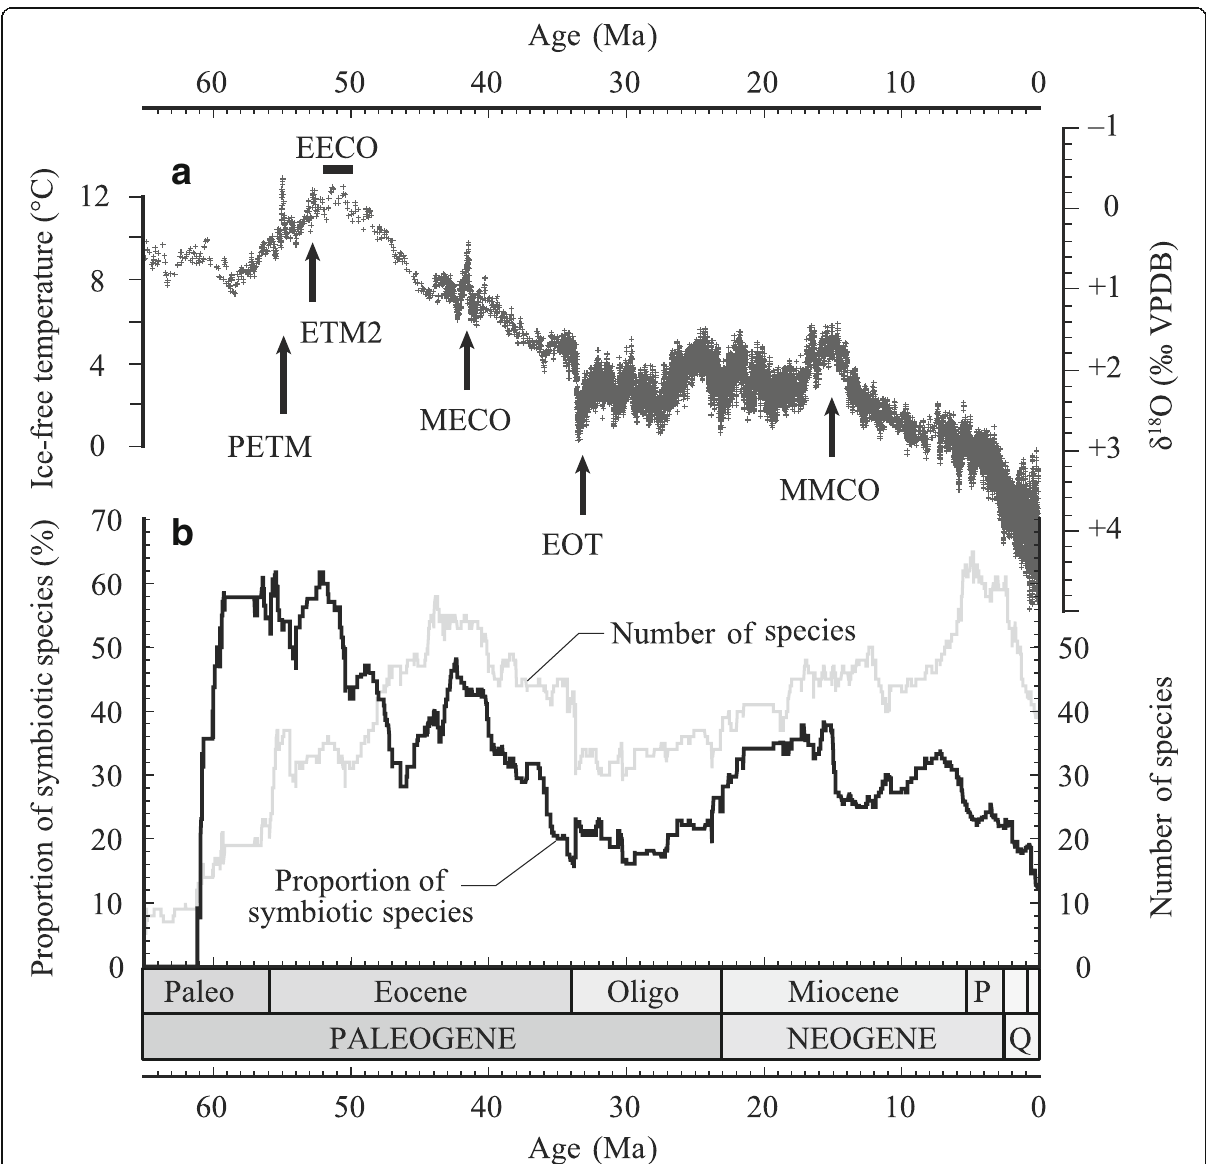
Fig. 17 Cenozoic climate changes and paleodiversity dynamics of planktic foraminifera. a Cenozoic climate change reconstruction from the stable oxygen isotope profile of deep sea benthic foraminifera (Zachos et al. 2008). b Changes in species number and proportion of photosymbiotic species (original data and categorization of photosymbiotic group are from Aze et al. 2011). PETM Paleocene Eocene thermal maximum, ETM2 Eocene thermal maximum 2, EECO Early Eocene climatic optimum, MECO Middle Eocene climatic optimum, EOT Eocene Oligocene transition, MMCO Middle Miocene climatic optimum, Paleo Paleocene, Oligo Oligocene, P Pliocene, Q Quaternary. After the rapid emergence of photosymbiotic species in the Paleocene, the proportion of photosymbiotic species fluctuate with a good correspondence to the climate. The proportion increased during warmer periods like PETM, EECO, and MECO, which indicate the advantage of photosymbiotic ecology during such a hot